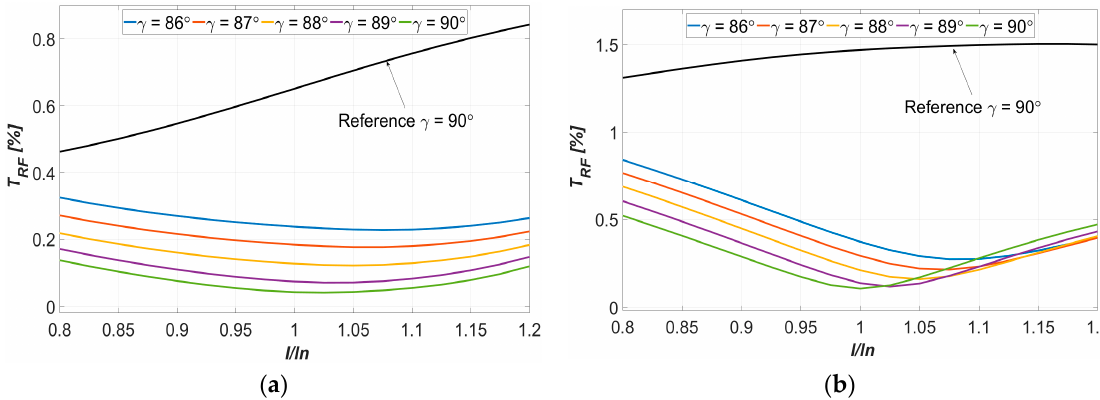
Figure 8. Torque ripple vs. relative current characteristics for different values of the torque angle γ ( a ) machine no. 1 of n s / n p equal to 9/10 and ( b ) machine no. 2 of n s / n p equal to 9/8.